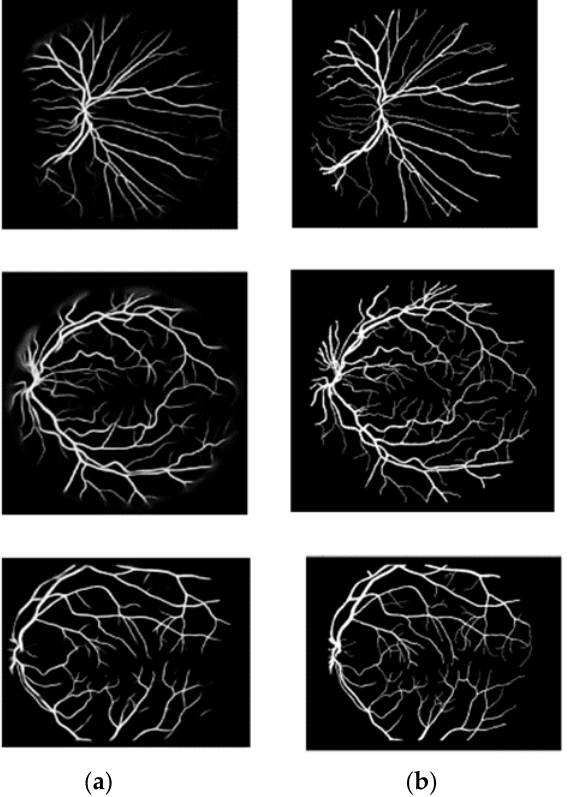
Figure 7. Segmentation results using the proposed model. ( a ) Results of automated segmentations by our model; ( b ) Corresponding manual segmentations.